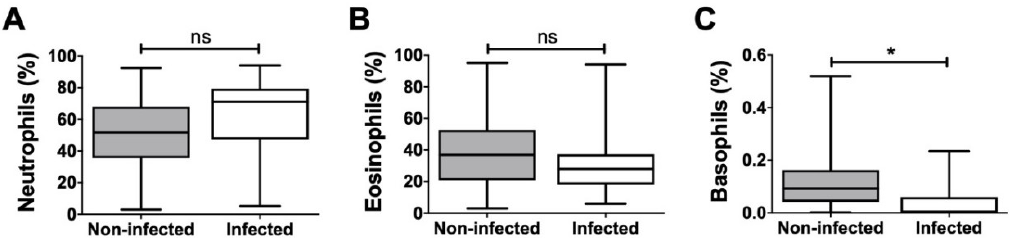
Figure 6. Proportion of granulocyte subpopulations in relation to total granulocytes. Percentage of ( A ) neutrophils, ( B ) eosinophils and ( C ) basophils for both non-infected and infected samples are shown. Only basophils showed a significant difference between non-infected and infected samples. * p < 0.05, ns: non-significant.